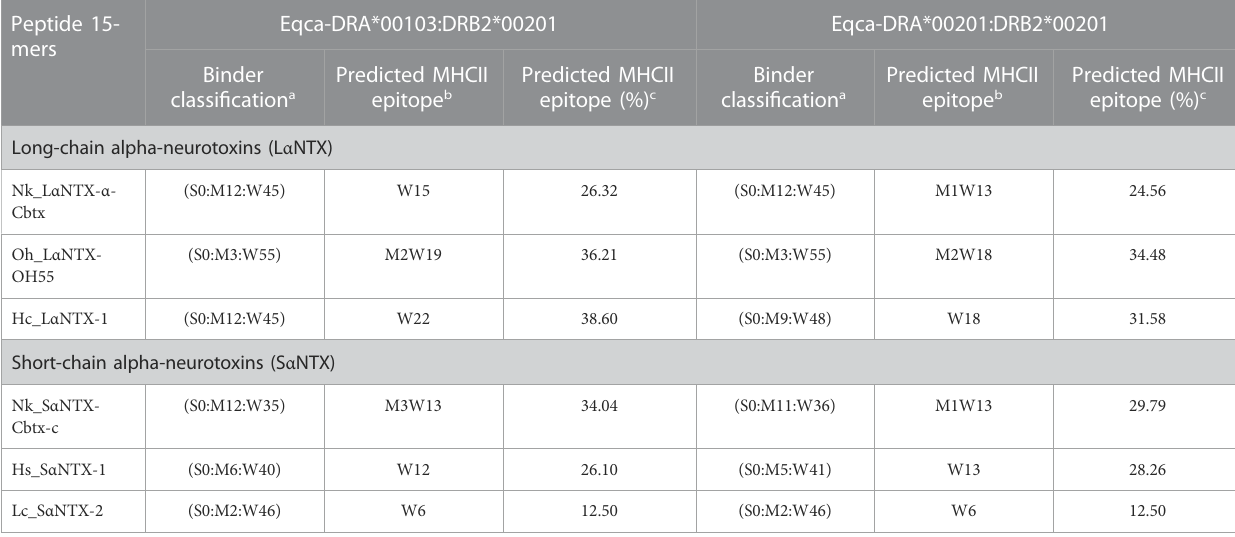
TABLE 2 Clustering of display and non-display decoys (Eqca-DR:15-mer) based on HADDOCK scores. Peptide 15- mers